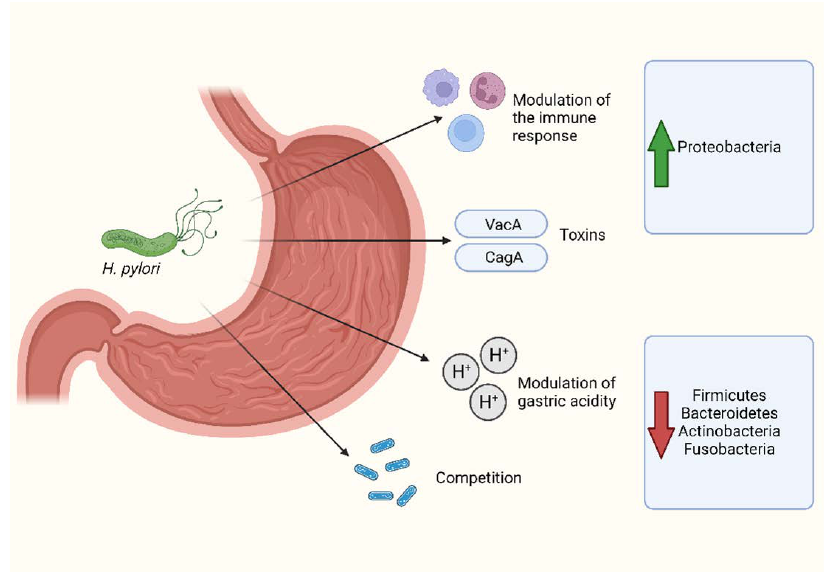
Figure 1. Main mechanisms mediating the relationship between H. pylori and gastric microbiota. Created with